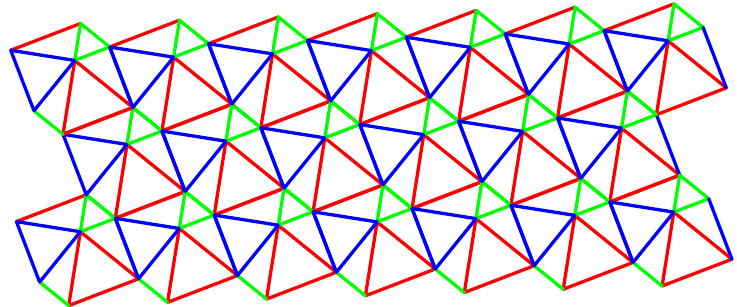
Fig. 18: Tiling with three different regular triangles and one type of non-isosceles triangle